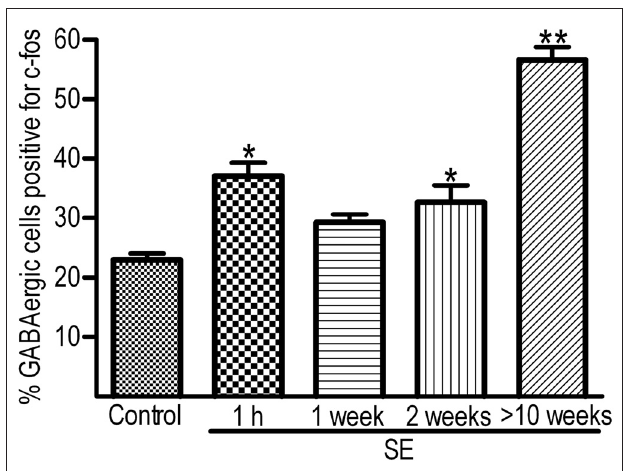
FIGURE 3 | Percentages of hilar GABAergic cells positive for c-fos at 1 h, 1 week, 2 weeks and more than 10 weeks after SE . SE was induced by an intraperitoneal injection of pilocarpine. The controls (Control, n = 12) received equal volume of normal saline instead of pilocarpine. Because the percentages of GABAergic cells positive for c-fos in the controls examined at 1 h, 1 week, 2 weeks, or more than 10 weeks are not statistically different, data obtained at the above mentioned time points are pooled together. The number of animals in the SE group at 1 h, 1 week, 2 week and more than 10 weeks after SE onset is 4, 4, 4, and 7, respectively. Multiple comparisons were carried out with Dunnett’s test following one-way ANOVA. ∗ p < 0.01 and ∗∗ p < 0.001, as compared to